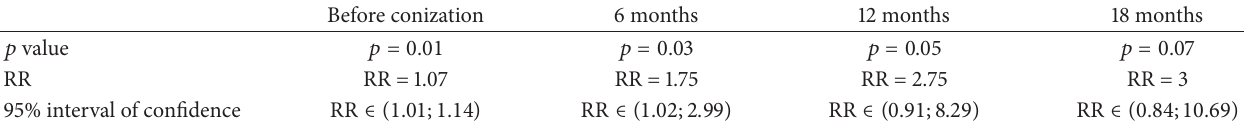
Table 4: The 𝑝 value obtained using 𝜒 2 test, comparing coinfections including HPV 16 + other HPV types, with coinfections without HPV 16. Coinfection including type 16 was correlated with higher persistence rate than coinfections without type 16.